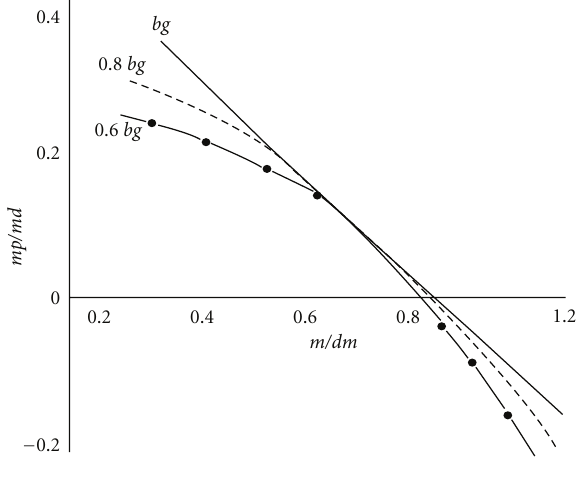
Figure 30: Flow inside bleed out from the port.